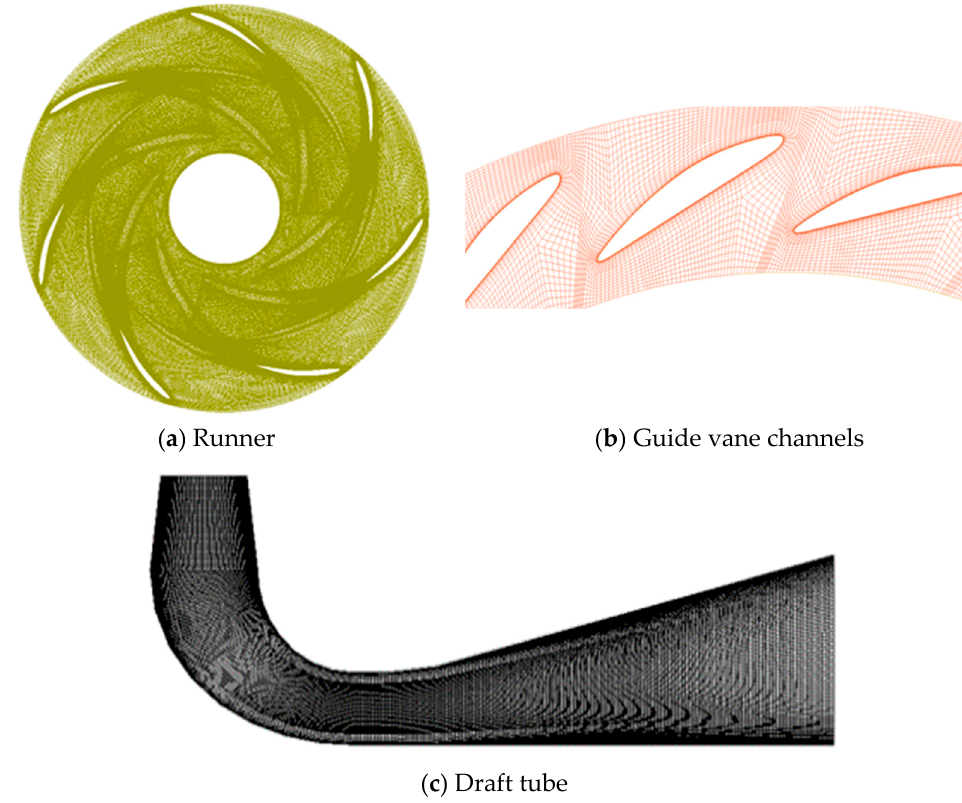
Figure 3. Mesh of major hydraulic components.